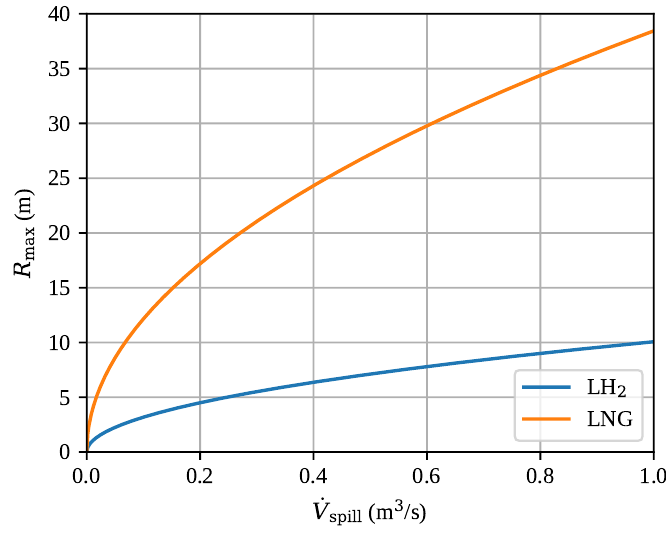
Figure 5. The estimated maximum radius of a steady-state spill R max as a function of the volumetric spill rate ˙ V spill . The results are based on the analytical model (Equation (4)).